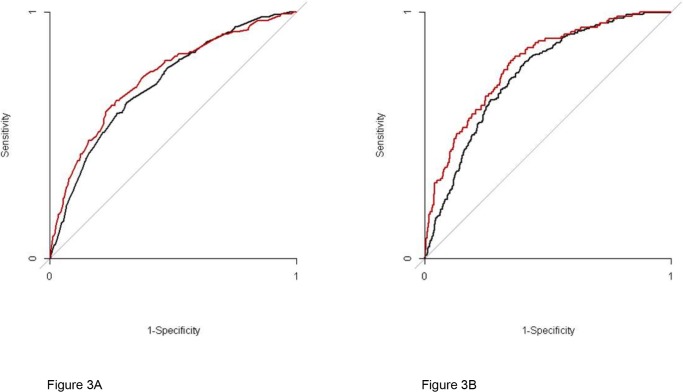
ROC curves of model 1, A, consisting of symptoms.The black line describes the diagnostic value in men and the red line the diagnostic value in women. The AUC in women is not inferior to the AUC in men, p-value 0.45. ROC curves of model 2, B, consisting of symptoms added with baseline characteristics. The black line describes the diagnostic value in men and the red line in women. The AUC in women is not inferior to the AUC in men, p-value 0.11.